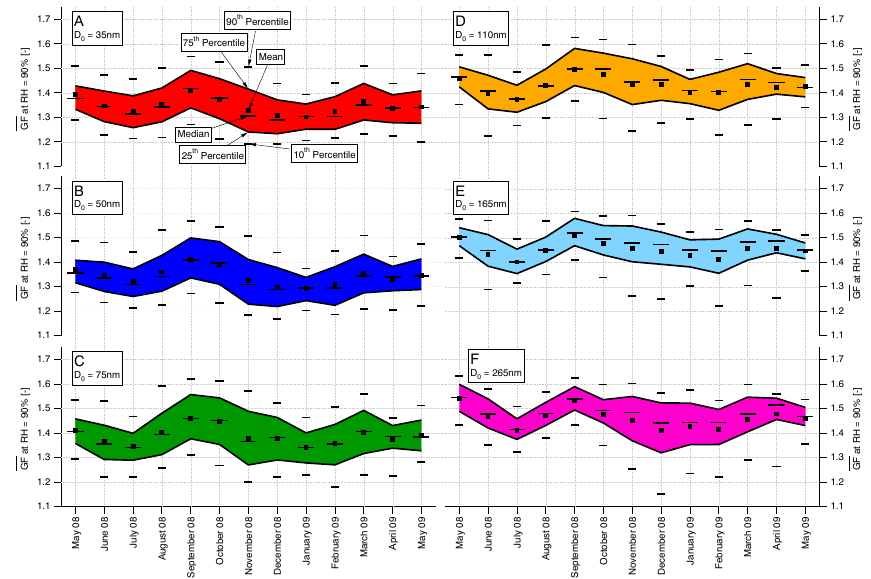
Fig. A1. Monthly statistics of the variability of the mean hygroscopic growth factor (GF) at 90% RH. The 10th, 25th, 50th (median), 75th, and 90th percentiles as well as the mean value of GF are shown in panels A-F for D 0 =35, 50, 75, 110, 165, and 265nm. The GF range spanned by the 1st and 3rd quartiles is highlighted with a shading.